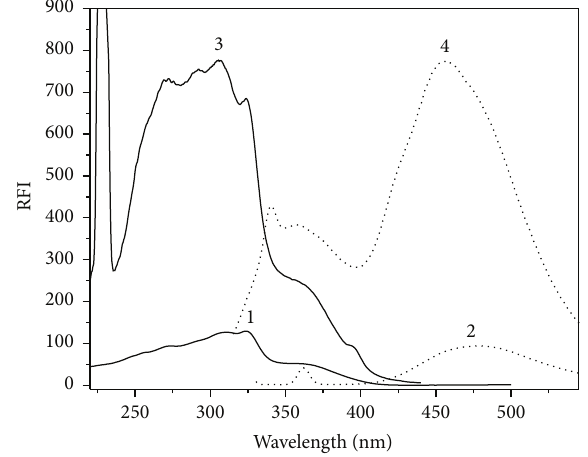
Figure 2: Fluorescence spectra representing (1) excitation and (2) emission of PTB in water (40ngmL −1 ); (3) excitation and (4) emission (40 ngmL −1 ) of PTB in Cr RH 40 (1%,